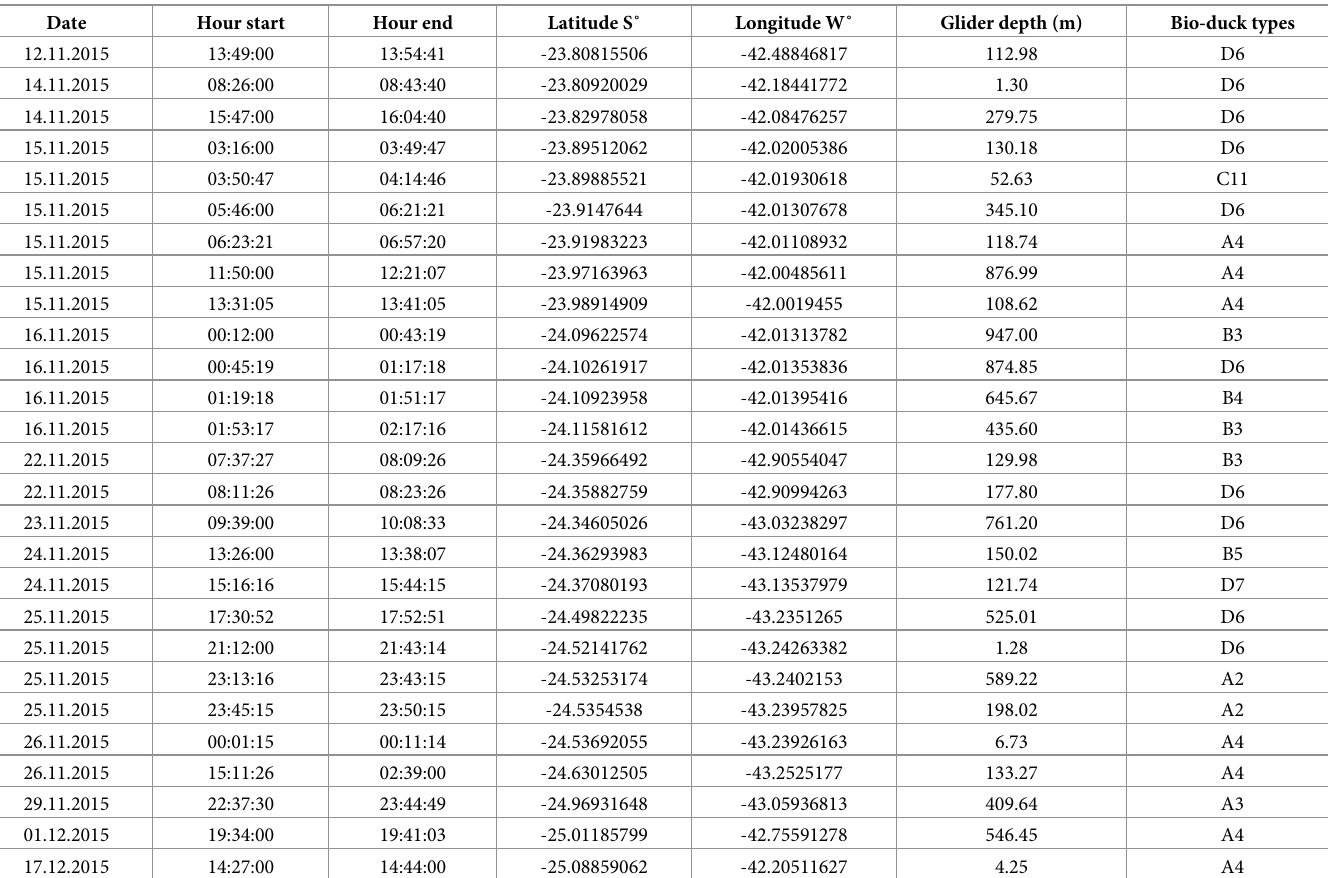
Table 1. Antarctic minke whale Bio-duck call encounters in Brazilian offshore waters.